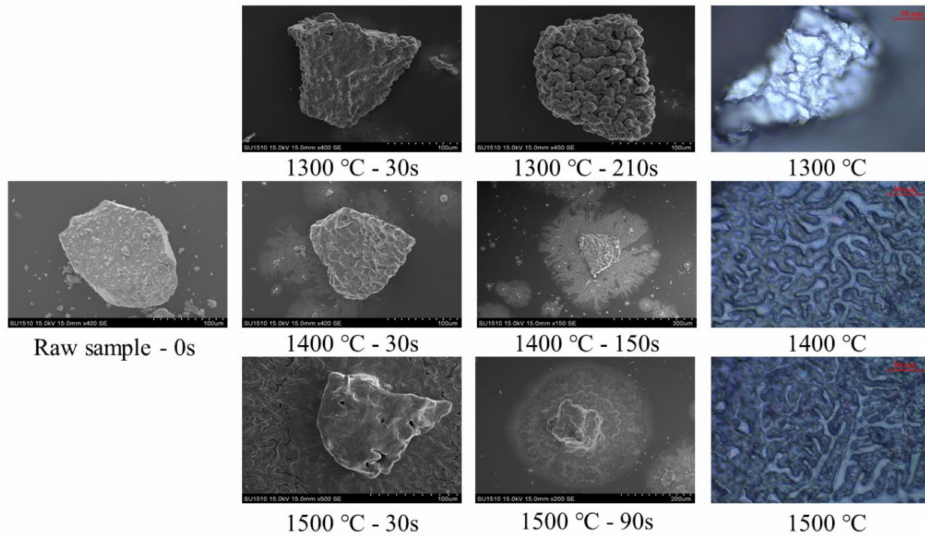
Figure 6. SEM images and experimental photos of particles before/during/after the reduction process at different